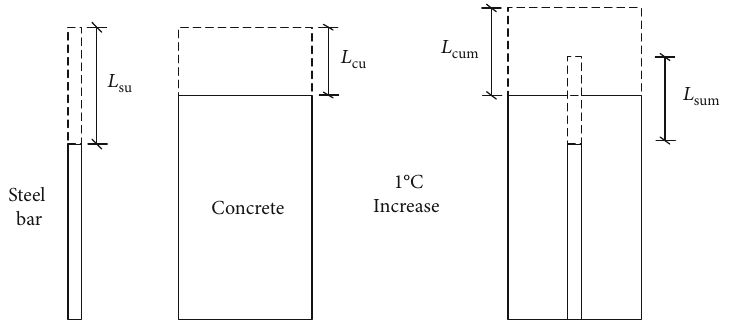
Figure 4: Changes in structure with increasing temperature.